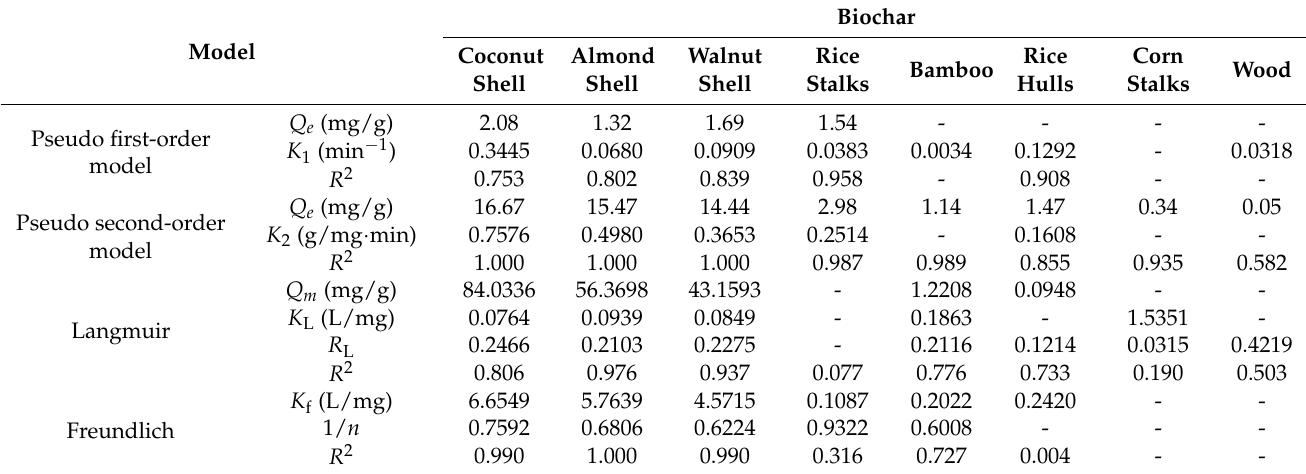
Table 3. Parameters of adsorption kinetics and adsorption isotherm